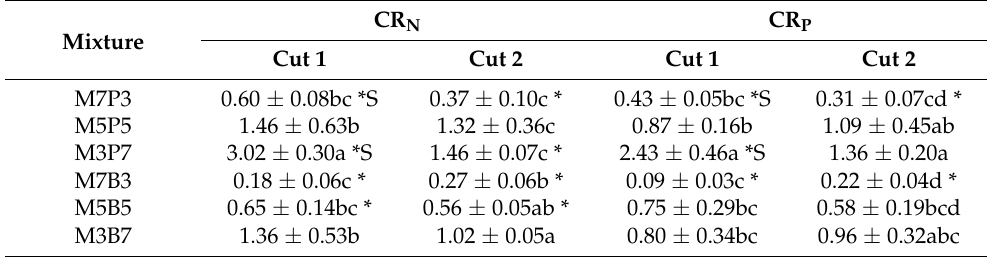
Table 6. Competition ratios for N (CR N ) and P (CR P ) of lucerne under different mixtures. CR N Mixture